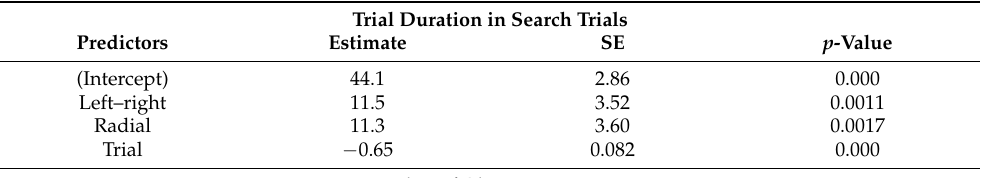
Table A3. Results of the analysis of trial duration in navigation trials. The applied model was a linear mixed-effects model that considered both random intercept and random slope.